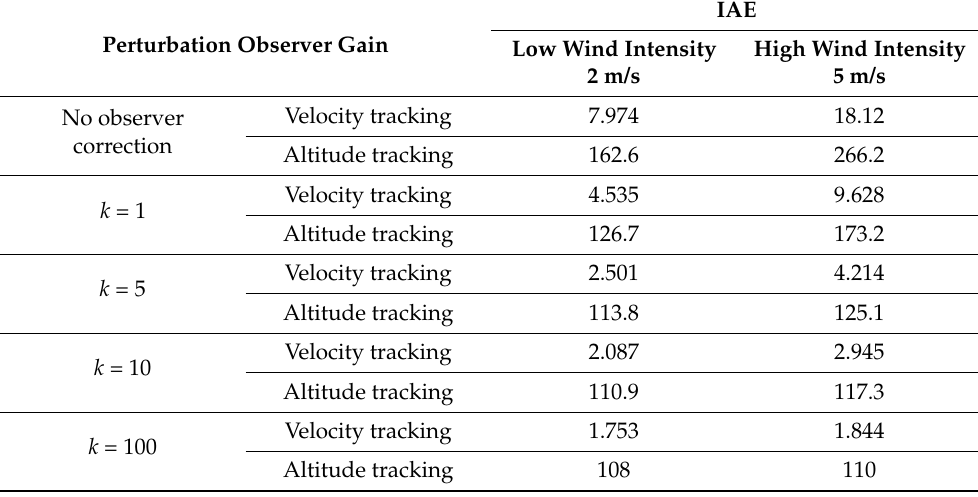
Figure 11. Trajectory tracking comparison for a climb-cruise-land quadplane trajectory under an average wind intensity of 5 m/s.